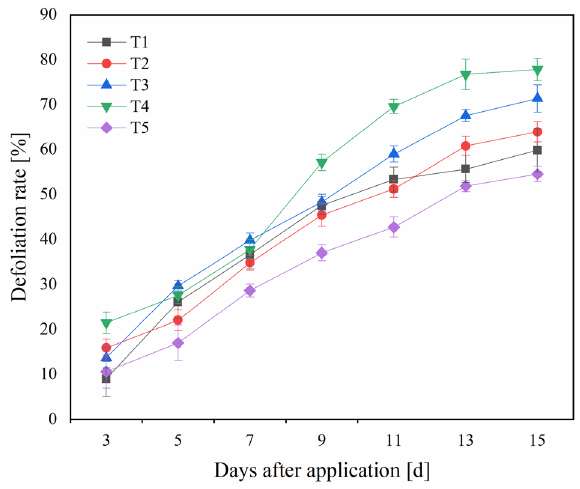
Figure 9. Defoliation rate 3–15 days after treatment. The detailed data of drawing the curve is shown in Supplementary Table S8.